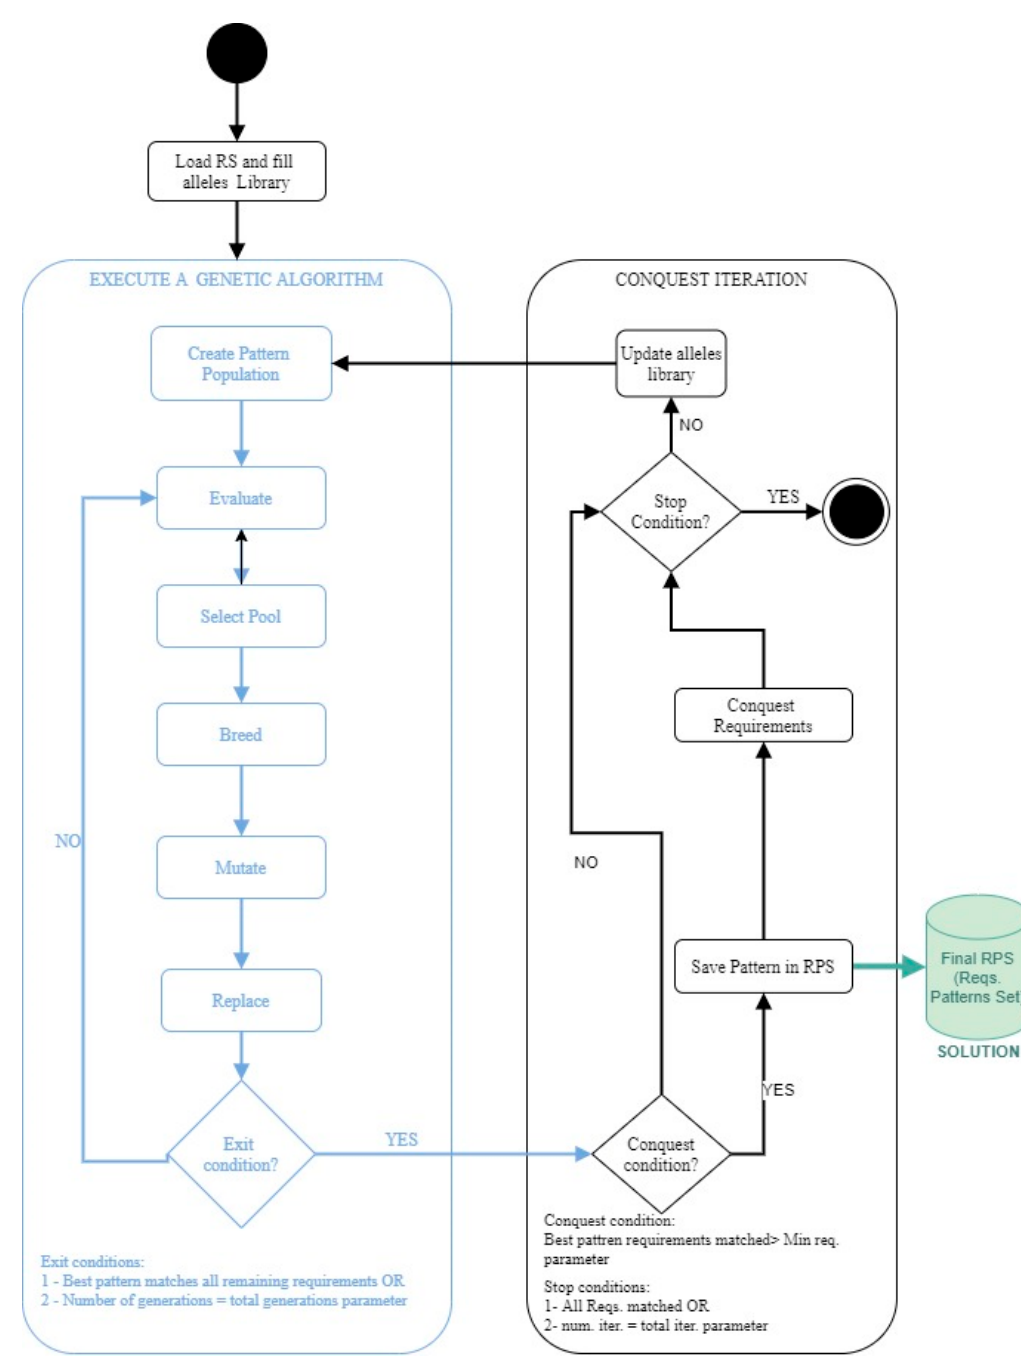
Figure 8. Diagram flow with the global algorithm.